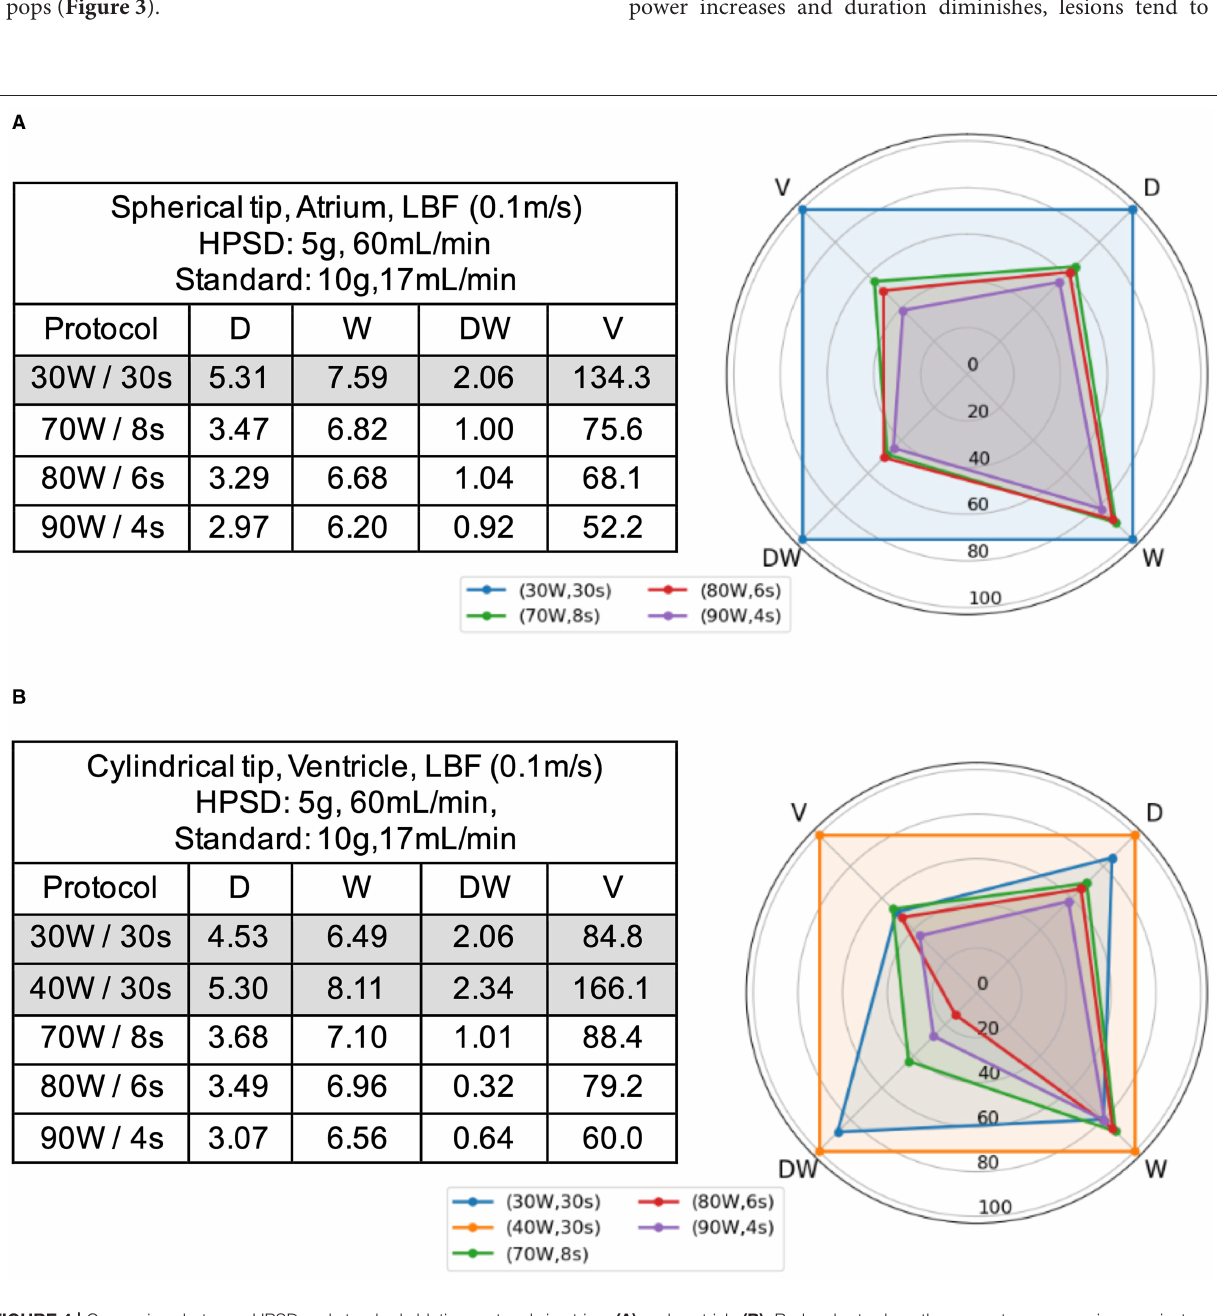
FIGURE 4 | Comparison between HPSD and standard ablation protocols in atrium (A) and ventricle (B) . Radar charts show the percentage comparison against a reference standard protocol (30 W/30s in the atrium, 40 W/30s in the ventricle). The associated tables present the absolute values. D, lesion depth; DW, Depth at maximum width; V, volume; W, lesion